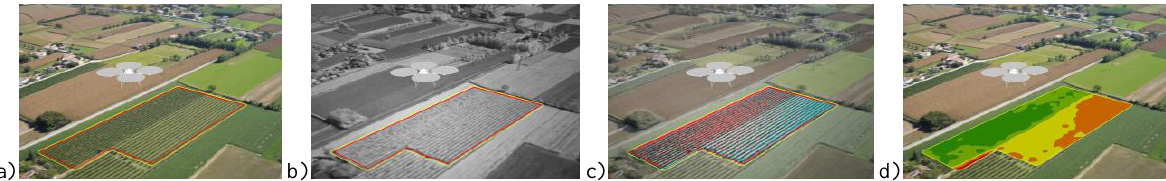
Figure 7: The studied wine yard area (a), seen in the NIR domain (b), with false colors (c) and the estimated NDVI index